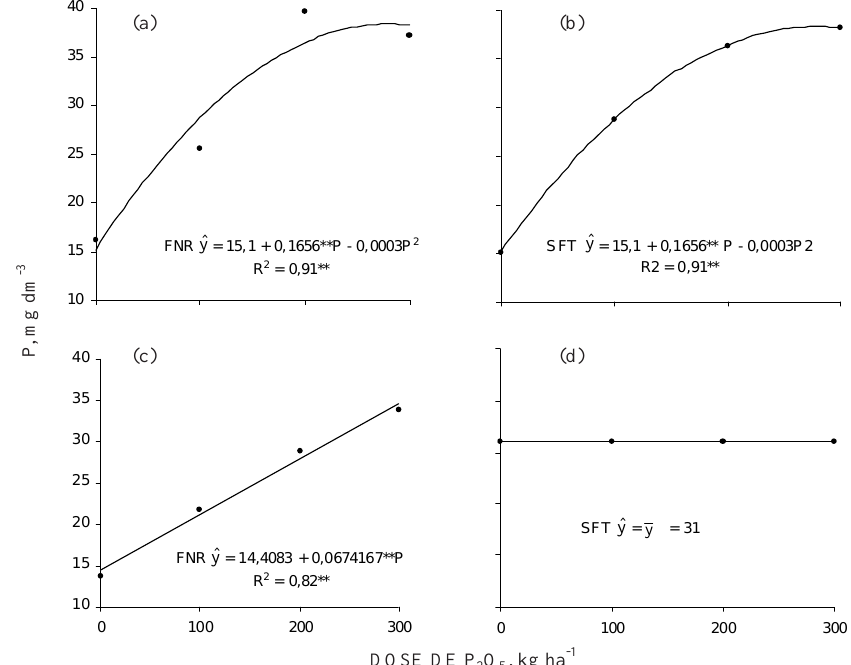
DOSE DE P 2 O 5 , kg ha